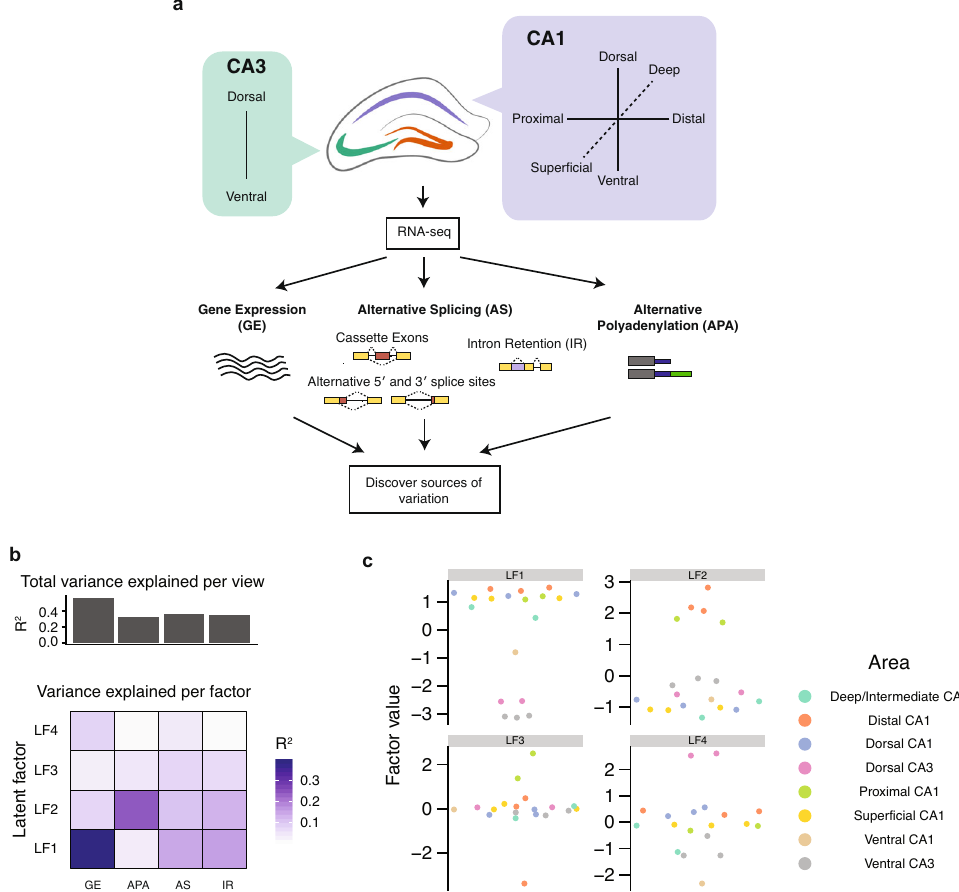
Fig. 1 Multi-layered RNA-seq analysis for investigating neuronal subtype diversity. a Schematic of the mouse hippocampus (center) and the various anatomical regions assayed by RNA-seq from Cembrowski et al. 28 . The hippocampus is broadly segmented into three sub fi elds: CA1 (purple), CA3 (green), and DG (orange, unlabeled). Computational methods were applied to generate multi-dimensional pro fi les of each transcriptome, including gene expression (GE), exon sequence alternative splicing (AS), intron retention (IR), and alternative polyadenylation (APA). Hippocampus schematic by Rayna Harris 77 , distributed under a Creative Commons Attribution License. b MOFA was applied to investigate the sources of variation that describe the differences between neuronal types. The total contributions of each layer, measured by total variance explained ( R 2 ), are summarized in the bar-plot (top panel). The individual contributions of each layer to each latent factor (LF) are summarized in the heatmap (bottom panel). c Beeswarm plots (one- dimensional scatterplots) illustrating the variation described by the top four latent factors inferred by MOFA. Each sample is assigned a factor weight ( y -axis) signifying its involvement in explaining the factor. MOFA captures sources of variability found between different regions